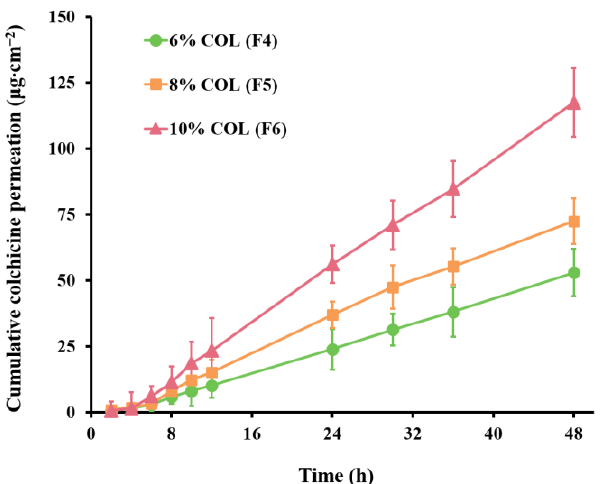
Figure 2. In vitro pig skin permeation profiles of colchicine (COL) from patches containing differ- ent contents of COL ( w / w %, based on PSAs dry weight) in Duro-Tak 87-2516 (mean ± SD, n = 6). Table 3. In vitro pig skin permeation parameters of colchicine from patches containing different